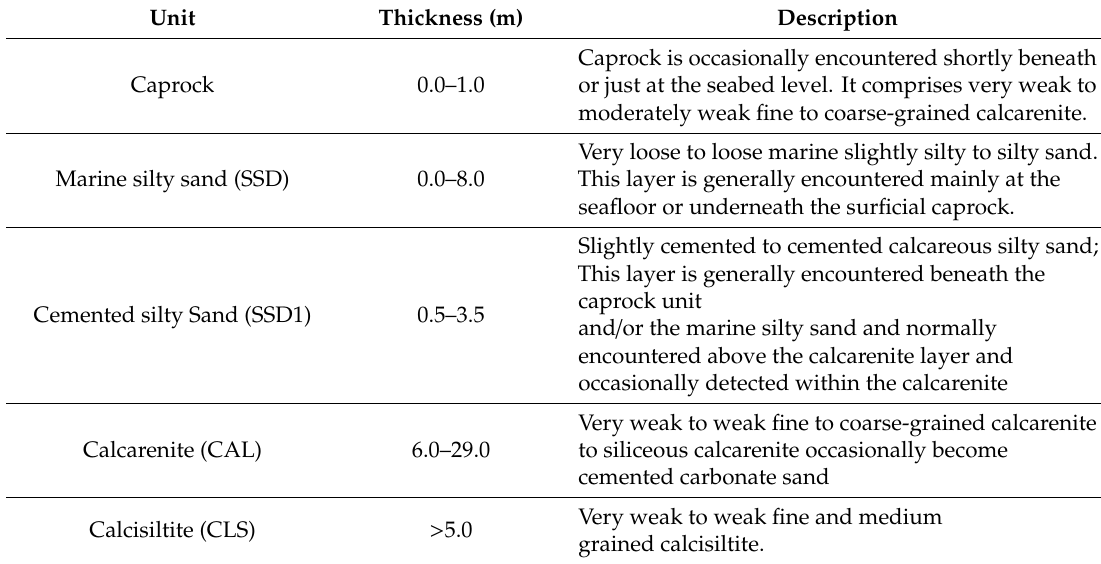
Table 1. Pre-reclamation site-specific stratigraphy